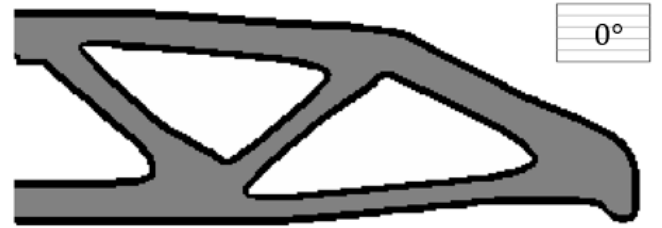
Figure 6. The optimized MBB beam.